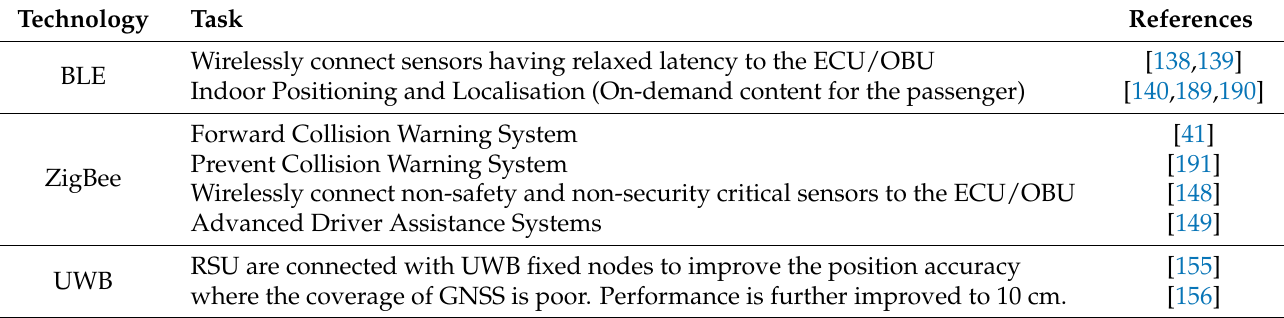
Table 8. Wireless technologies in